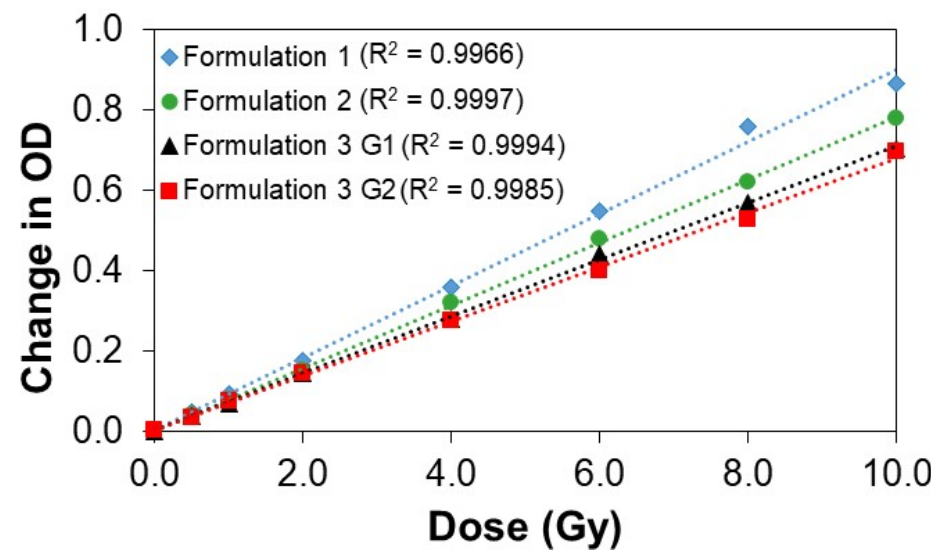
Figure 3. After the first irradiation, the initial cuvette dose response for Formulation 1, Formulation 2 and both groups of Formulation 3 (labeled G1 and G2 for group 1 and 2, respectively) are plotted above. Again, the least-squares linear fits are included as dotted lines along with the associated R 2 coefficient of the fit.